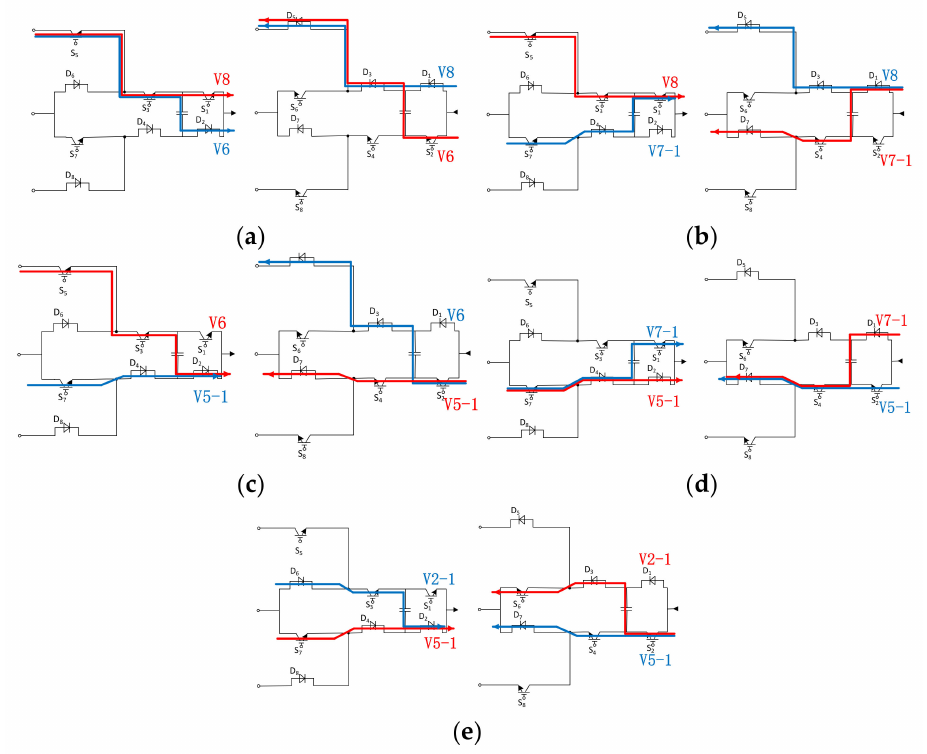
Figure 13. State cutover and current commutation. ( a ) V8 to V6. ( b ) V8 to V7-1. ( c ) V6 to V5-1. ( d ) V5-1 to V7-1. ( e ) V5-1 to